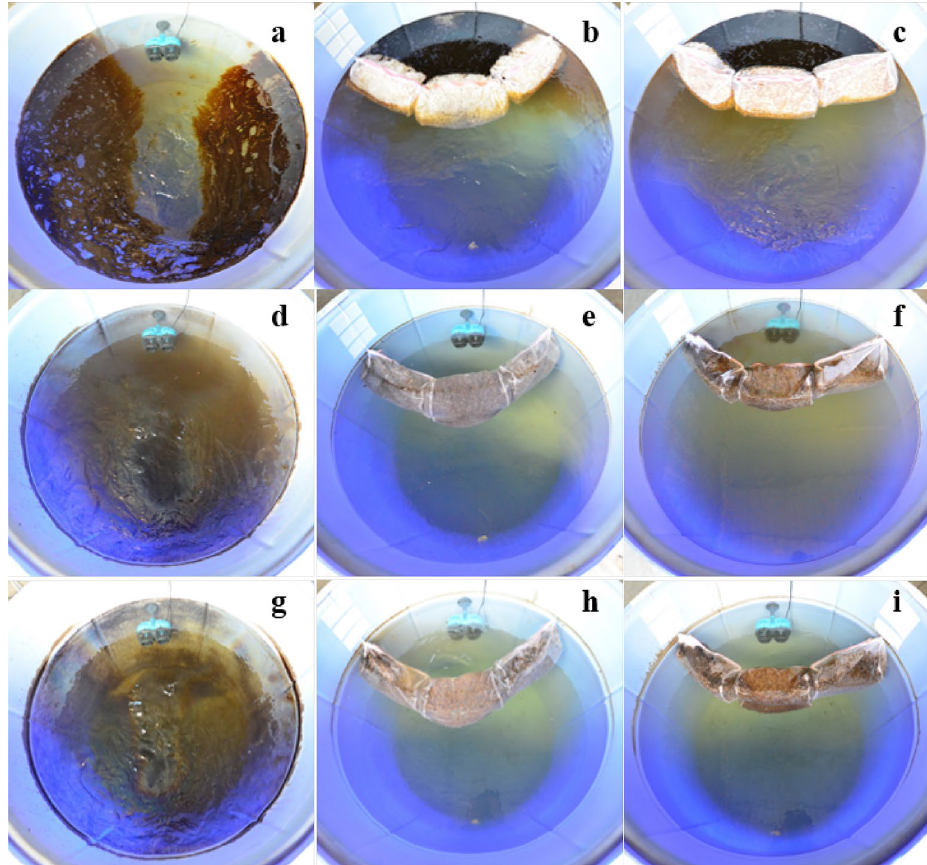
Figure 5. Visualization of crude oil removal by natural attenuation ( a , d and g ), control boom ( b , e and h ) and bioaugmentation with biobooms ( c , f and i ) in a simulated environmental mesocosm; 500-L freshwater